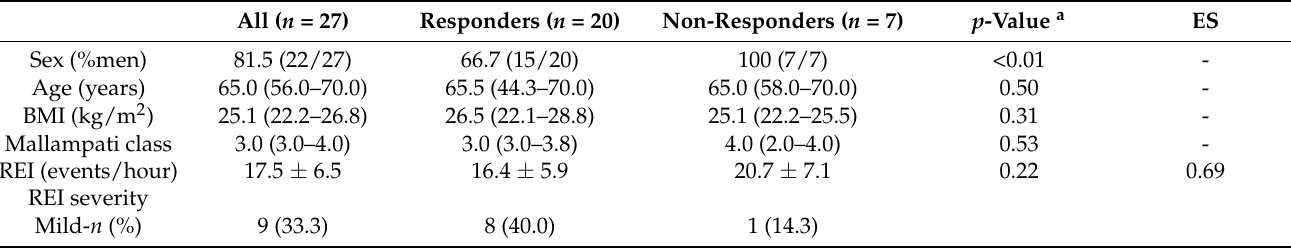
Table 1. Patient characteristics of the responders and non-responders receiving oral appliance (OA)